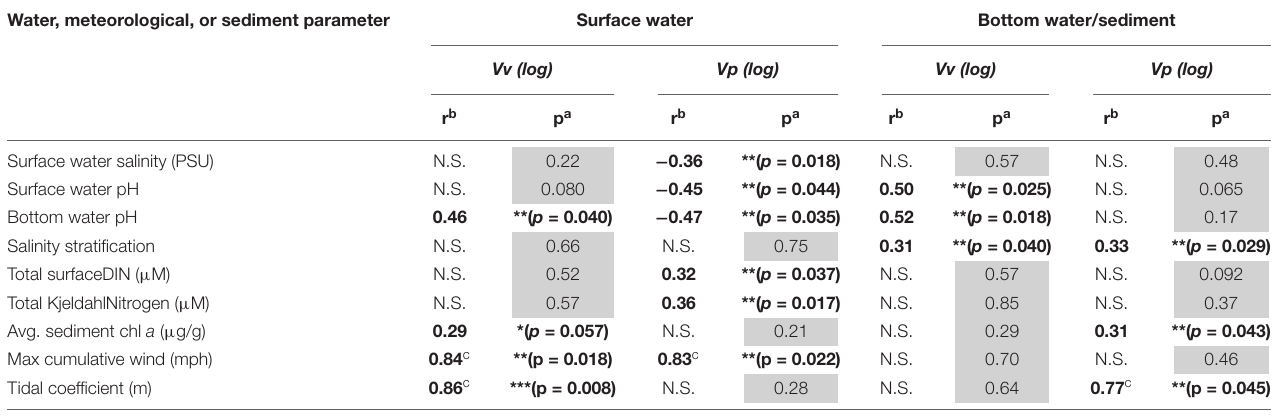
TABLE 5 | Correlations between Vibrio abundances and environmental parameters. Water, meteorological, or sediment parameter Surface water Bottom